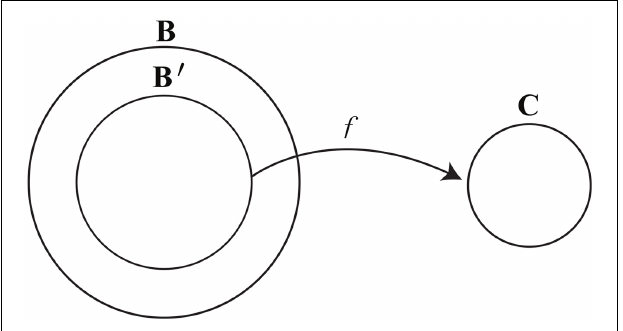
FIGURE 4 | Schematic of a supervenience